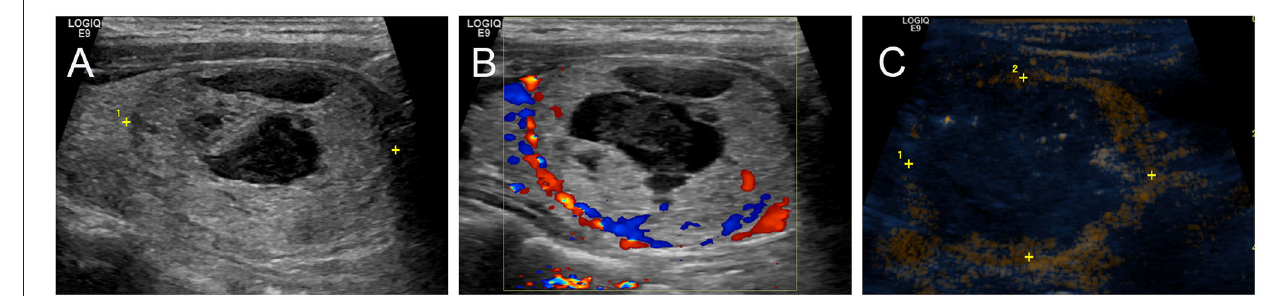
FIGURE 2 | Intraoperative CEUS evaluation: A 38-year-old female had a predominantly solid nodule in the left lobe of the thyroid. The nodule was close to the trachea, carotid artery, and danger triangle area. (A) US examination showed that the baseline volume of the nodule was 26.48ml, and the largest nodule diameter was 4.3cm. (B) CDU showed nodule vascularity was defined as type 1. (C) CEUS after initial RFA: the nodule showed non-enhancement during the phase.